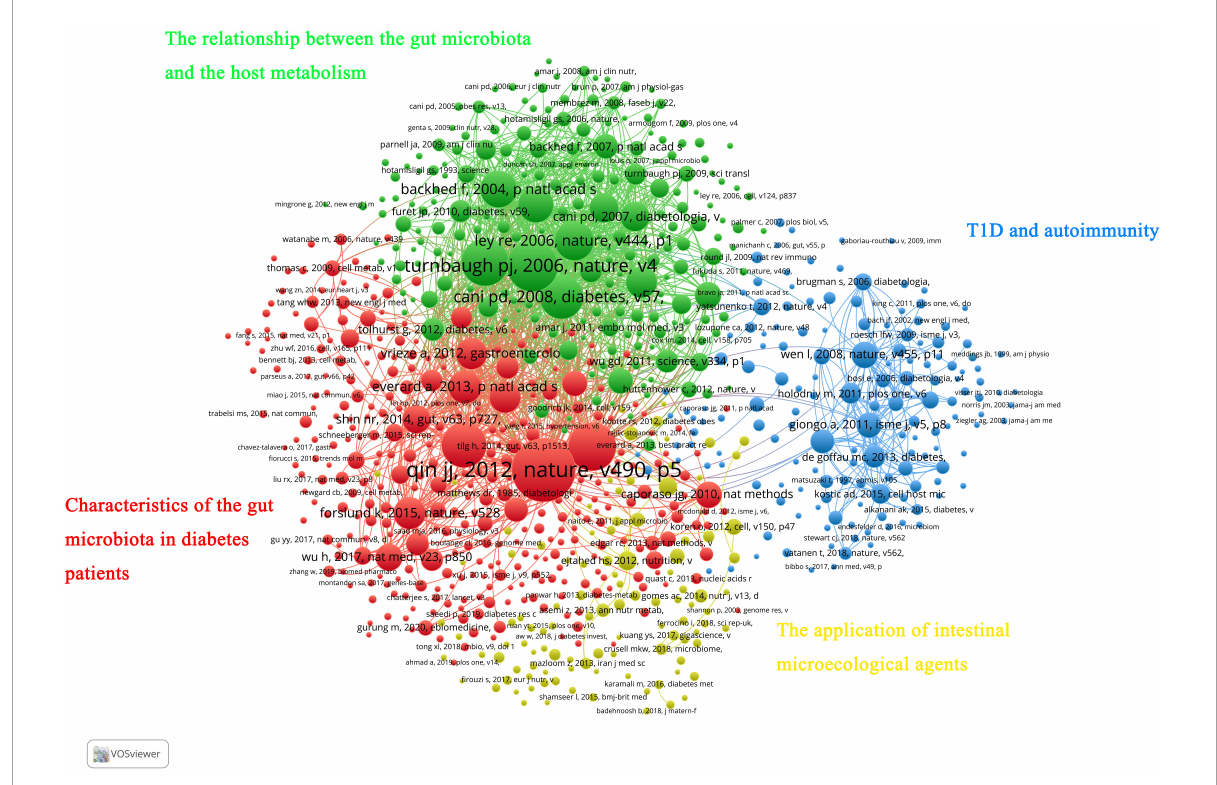
FIGURE6 VOSviewer network visualization map of co-cited